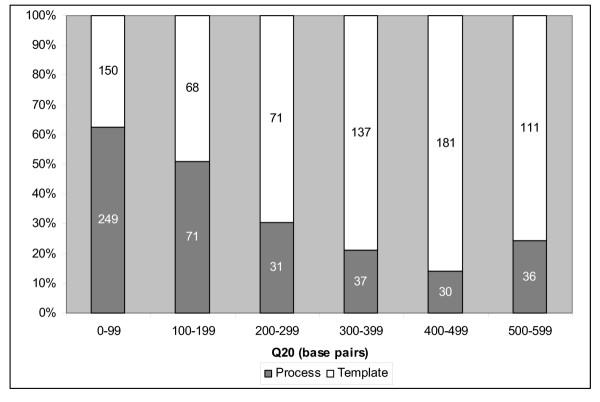
Distribution of overall process vs template failed reads Percentage of process versus template-related failures for each 100 bp Q20 read length bin. Numbers in each column represent the number of reads in each bin category. Process-related failure modes are more prevalent in lower average Q20 read lengths. Template-related failure modes are more prevalent in higher average Q20 read lengths.